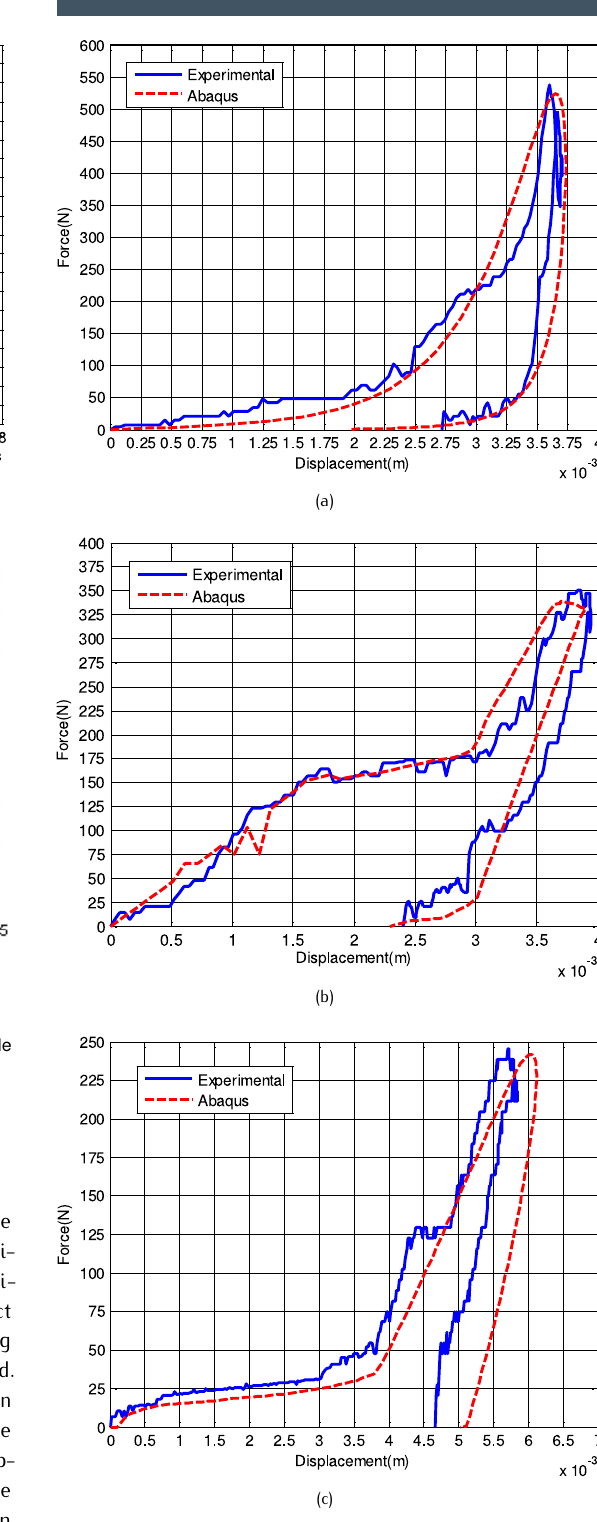
Figure 16. Numerical comparison of contact force versus displace- ment in the case of drop height (H = 0.5 m): (a)